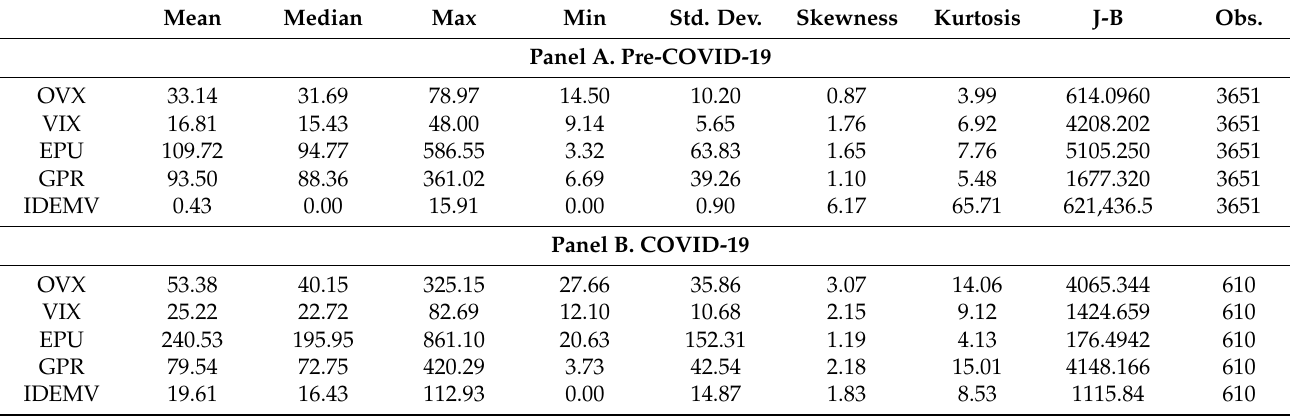
Table 1. Descriptive